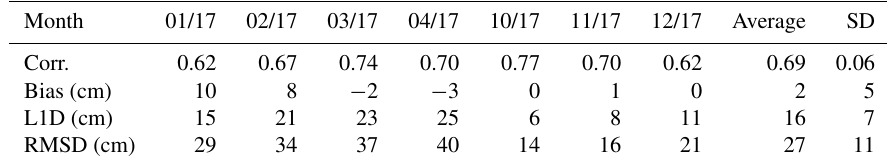
Table 6. Comparison between the CS2 SIT assigned to SAR mosaic segments and CS2SMOS SIT. Month 01/17 02/17 03/17 04/17 10/17 11/17 12/17 Average SD Corr. 0.55 Bias (cm) RMSD (cm) Table 7. Comparison between the CS2 assigned to SAR mosaic segments with the mapping and CS2SMOS SIT. Month 01/17 02/17